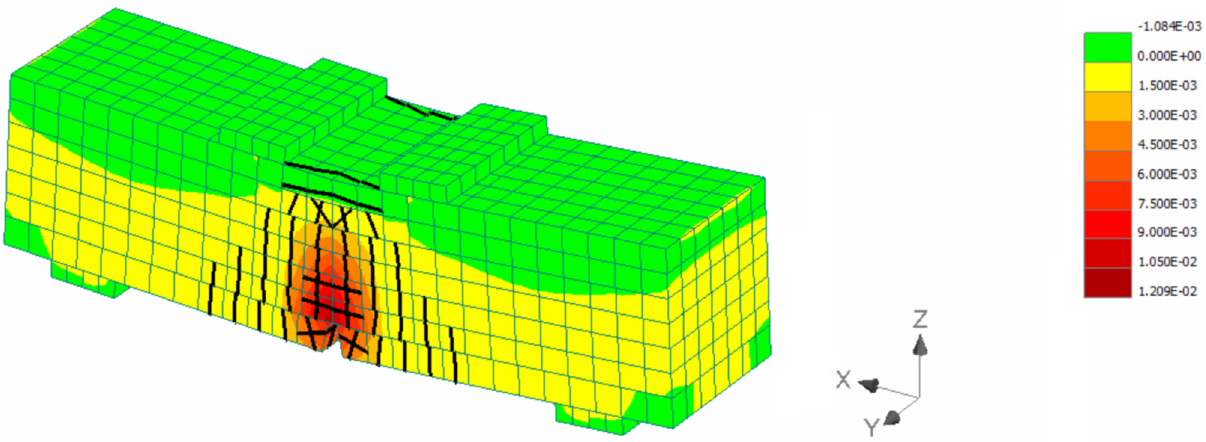
Figure 13. Indicative strain distribution at the maximum load. The load deflection results of the numerical analyses are compared to the experimental and the results are illustrated in Figure 14. The thinner, colored lines resemble the experimental load deflection data obtained per specimen loaded under bending.